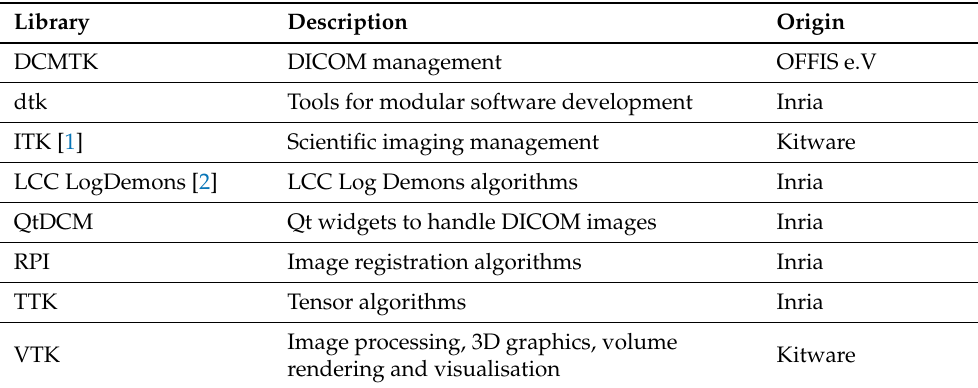
Table 1. External libraries used in medInria, core of